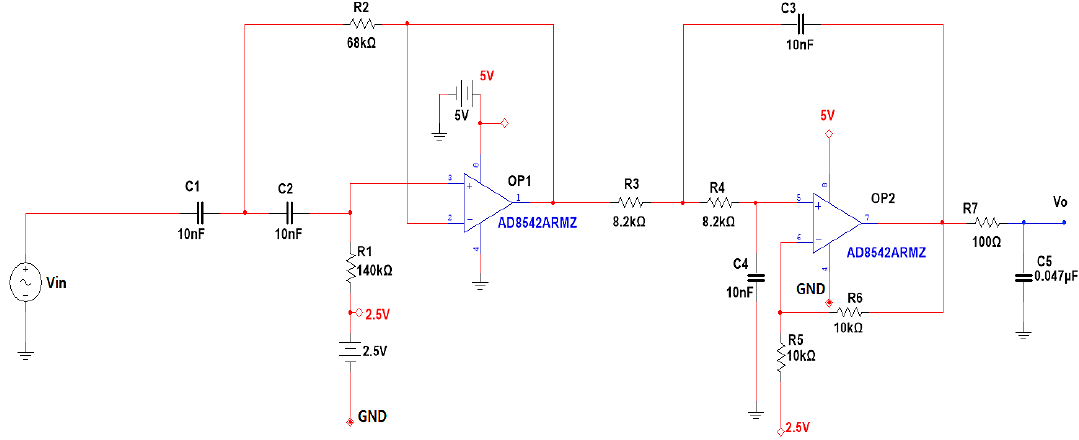
Figure 25. Overall schematic of the designed Band-pass filter based on Sallen–Key cells.